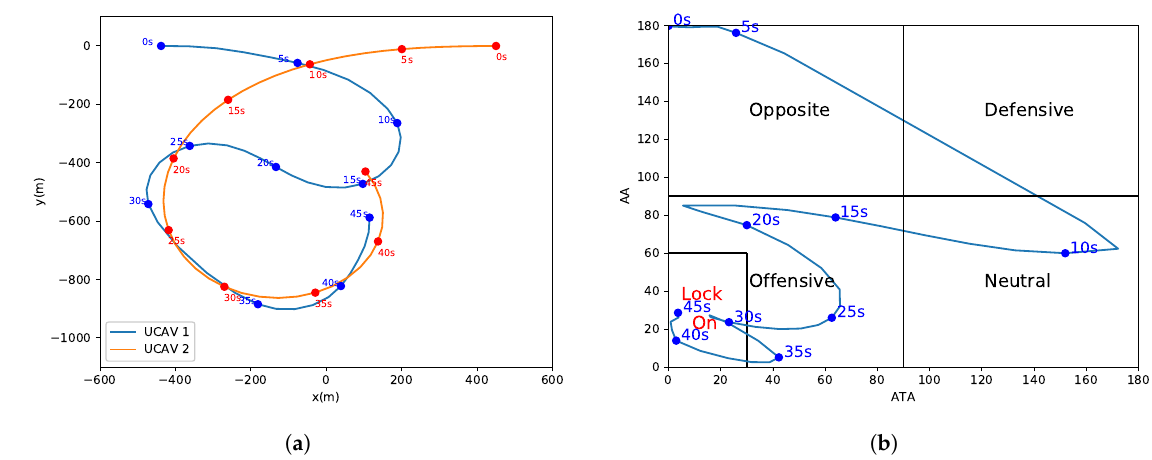
Figure 9. ( a ) Curve of the fly trajectory against “decelerate left turn” strategy. ( b ) Curve of the change of air combat situation against “decelerate left turn” strategy.